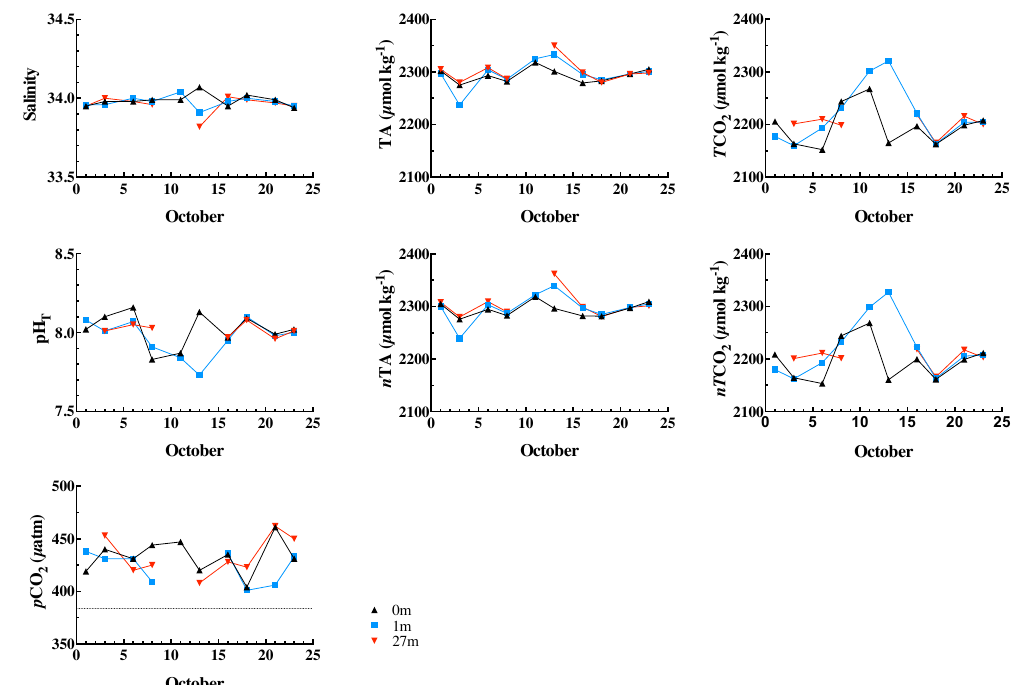
Figure 7. Evolution of salinity, pH T , TA (in µmolkg − 1 ) , n TA (TA normalized to a salinity of 34, in µmolkg − 1 ), calculated T CO 2 (in µmolkg − 1 ) and nT CO 2 ( T CO 2 normalized to a salinity of 34, in µmolkg − 1 ), and in situ p CO 2 (in µatm) in the underlying seawater at the ice-water interface and 1 and 27m below the ice-water interface. The dotted line represents the atmospheric p CO 2 in 2007.